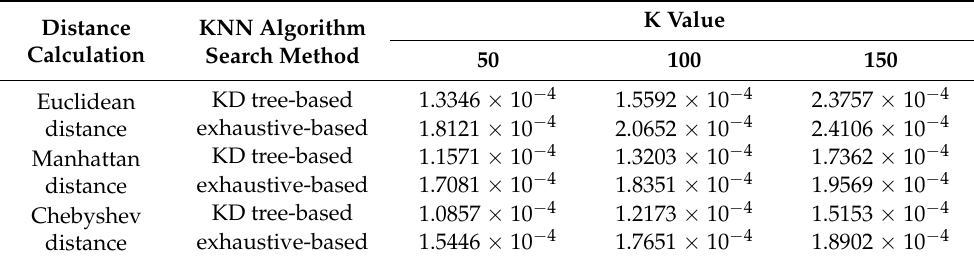
Table 4. Algorithm running time comparison (unit: